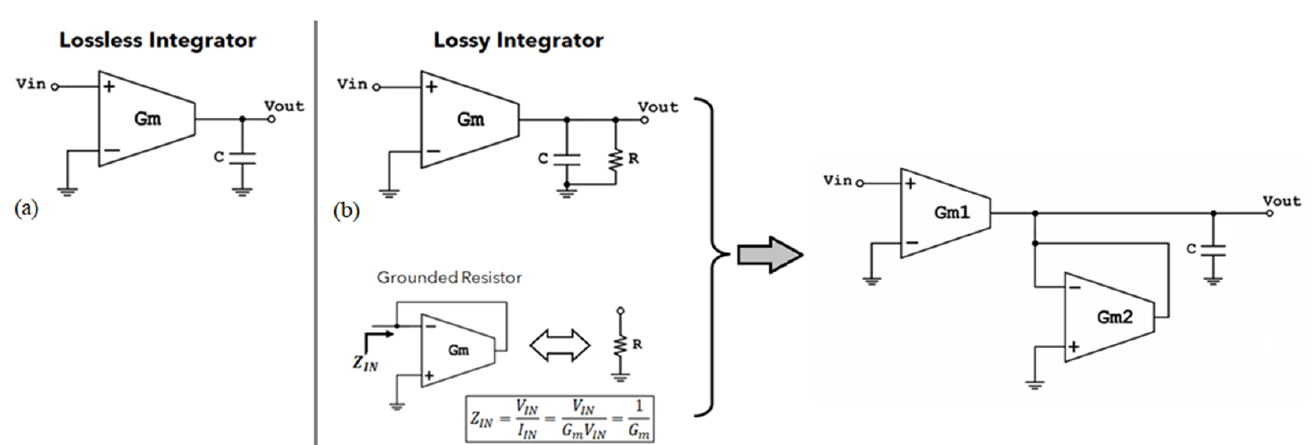
Figure 8. ( a ) Lossless integrator, ( b ) Lossy integrator with element replacement.